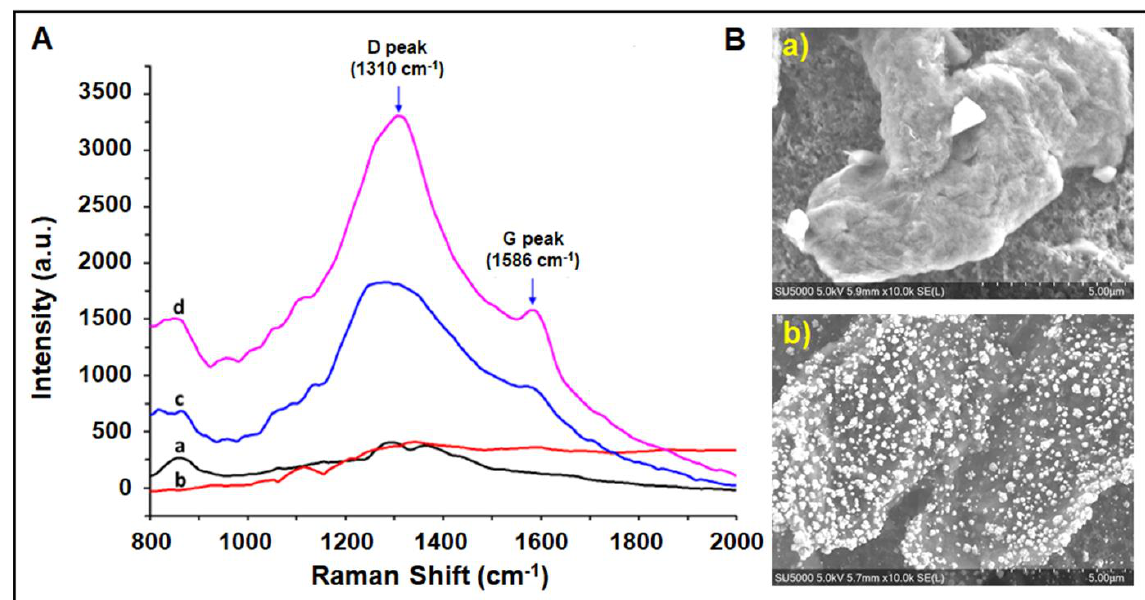
Figure 1. ( A ) Raman spectra of (a) nitrocellulose membrane (black), (b) carbon paste (red), (c) RGO-modified paper electrode (blue), (d) RGO-modified paper electrode after AuNP deposition (pink); ( B ) SEM images of (a) RGO and (b) AuNP/RGO-modified paper electrodes (scale: 5 µm). Gold deposition was performed with the chronoamperometric technique in aqueous solution of the HAuCl 4 gold precursor by applying −0.3 V for 10 min.